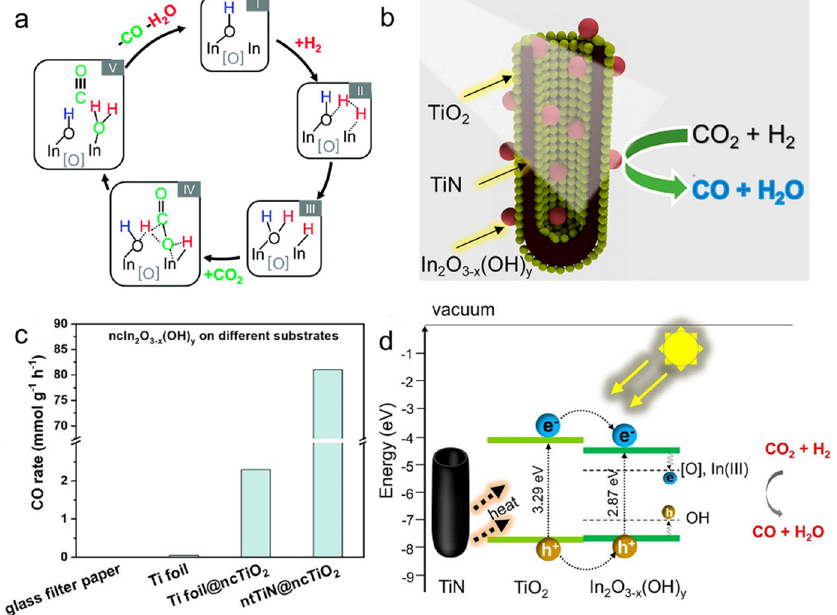
Figure 5. ( a ) Overall proposed mechanism for the RWGS reaction on In 2 O 3 − x (OH) y . Reprinted with permission from ref. [133]. Copyright 2015 Royal Society of Chemistry. ( b ) The schematic diagram of ntTiN@ncTiO 2 @ncIn 2 O 3 − x (OH) y . ( c ) nc In 2 O 3 − x (OH) y supported on different substrates (borosilicate glass microfiber filter paper, Ti foil, Ti foil decorated with ncTiO 2 , and ntTiN decorated with ncTiO 2 ). ( d ) Proposed activation mechanism for the photocatalytic reaction. Reprinted with permission from ref. [134]. Copyright 2021 American Chemical Society.